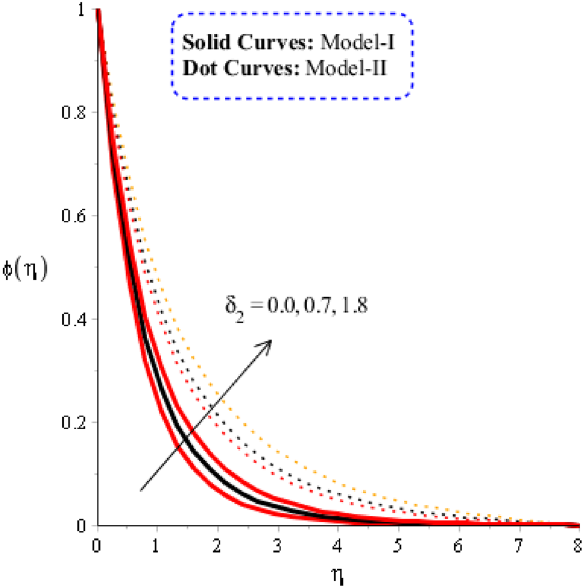
Figure 11. Graphical impact of δ 2 on concentration distribution when α = 0.5, m = 0.3, Re = 4.0, we = 3.0, M = 3.0, Pr = 206, K c = − 3.0, H t = − 2.0, Sc = 0.0, δ 1 = 0.4, ϕ 1 = 0.003, ϕ 2 = 0.004, ϕ 3 = 0.0075.